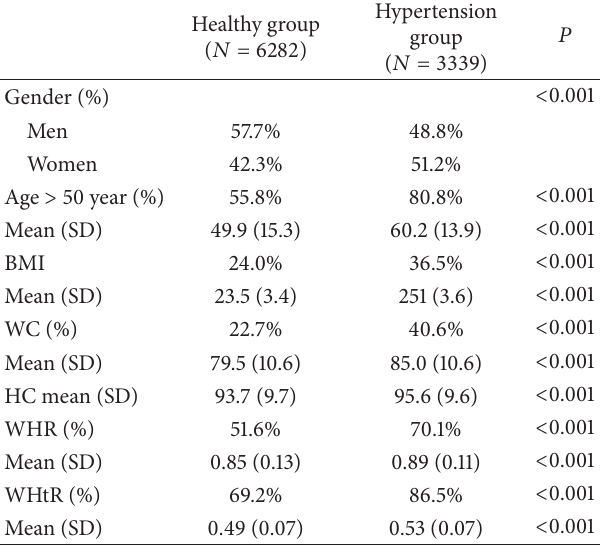
Table 1: A comparison of demographic information between healthy and hypertension groups.